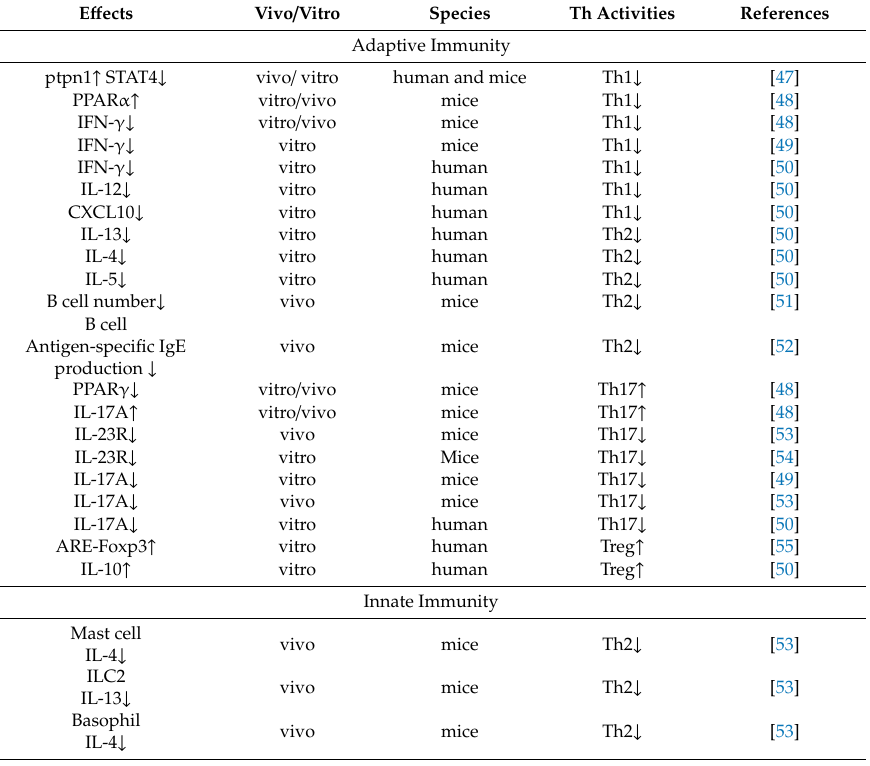
Table 4. Summary of the e ff ects of androgens on the activities of T helper 1 cell (Th1), Th2, Th17, and regulatory T cell (Treg). E ff